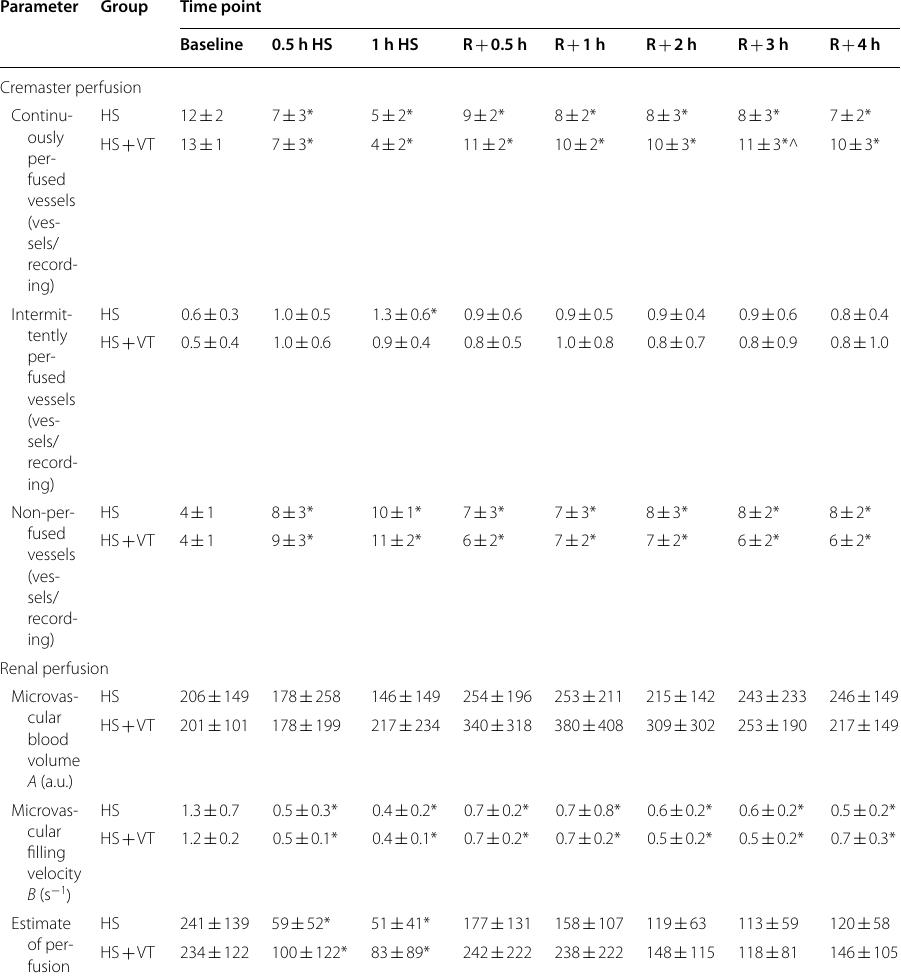
Table 2 Cremaster perfusion and renal perfusion